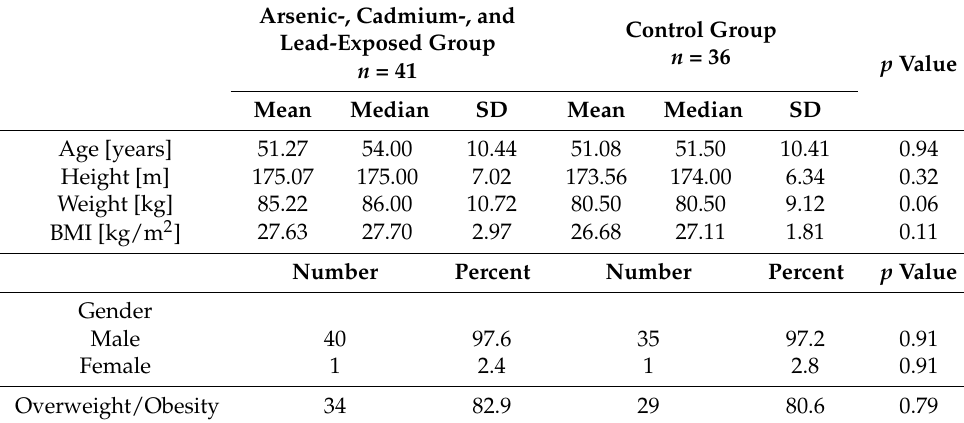
Table 1. General characteristics of the study groups. Arsenic-, Cadmium-, and Lead-Exposed